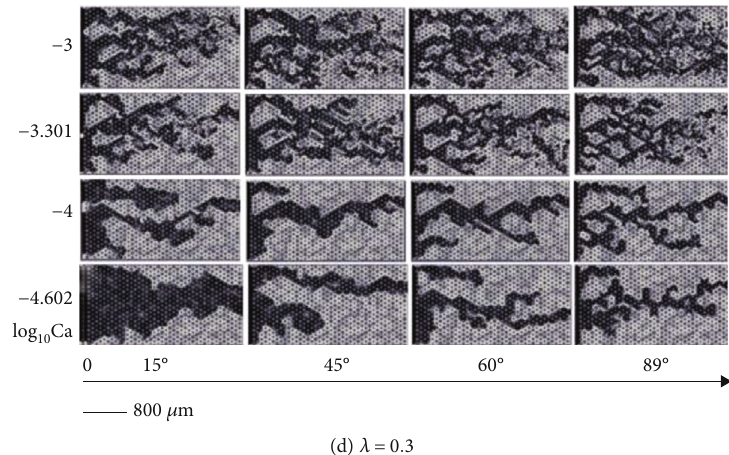
Figure 9: Displacement patterns for four di ff erent porous media with the di ff erent disorder [92].